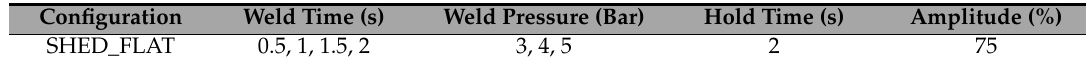
Table 3. Design of the experiment for the current